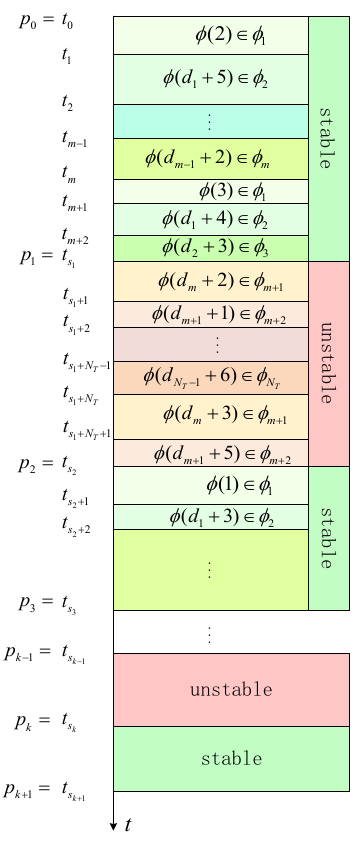
Figure 1. Illustration of quasi-cyclic switching